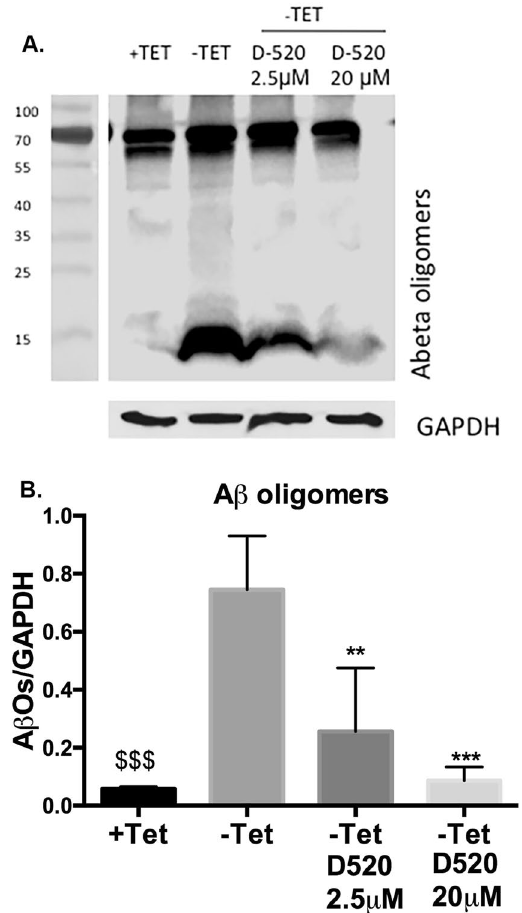
Figure 6. D-520 diminishes the intracellular population of A β oligomers: Western blots of extracts from MC65 cell lines that conditionally expresses C99, a 99-residue carboxyl terminal fragment of APP in the absence of tetracycline. C99 is subsequently cleaved by cellular γ -secretase to generate A β . The A β oligomers are seen when tetracycline is removed from the media. D-520 blocks the formation of A β oligomers. Immuno blotting was carried out using the antibody NAB-228 from Cell signalling (upper panel, Panel A)) and GAPDH was used as the loading control. The immuno blot images were quantified in the lower panel (Panel B). The plot shown is representative of 3 replicates. Standard marker as shown in the figure is part of the same gel (see the supplementary material section) and was developed with fluorescence exposure as described in the method section. The results shown is representative of 3 replicates, ** p < 0.01, *** p < 0.001 compared to –Tet and $$$p < 0.001 compared to